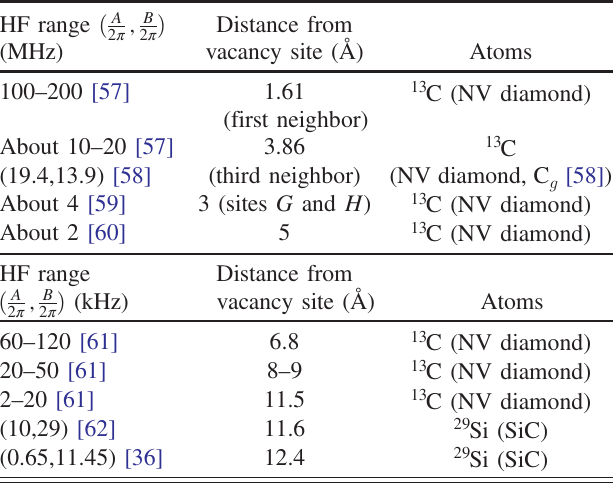
TABLE I. Range of hyperfine parameters and corresponding distances from the vacancy site for 13 C atoms and 29 Si atoms in diamond or SiC. Explicit values ð A; B Þ are shown in parentheses; otherwise, we provide approximate